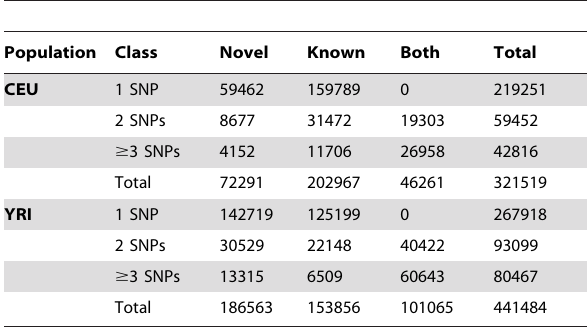
Table 3. Comparison with the SNPinProbe database(dbSNP